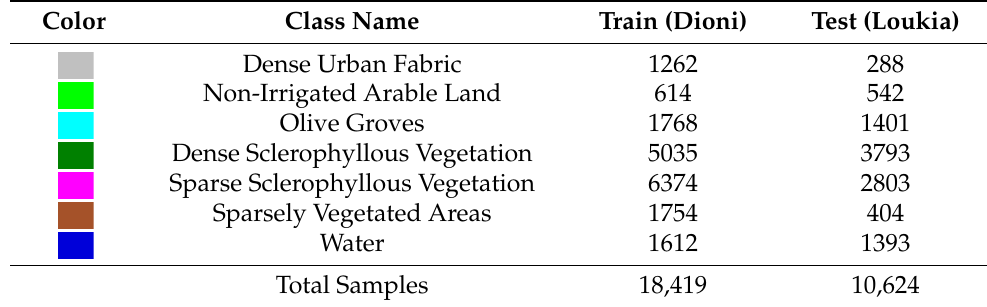
Table 5. The number of training and test samples in ISPRS HyRANK benchmark dataset.